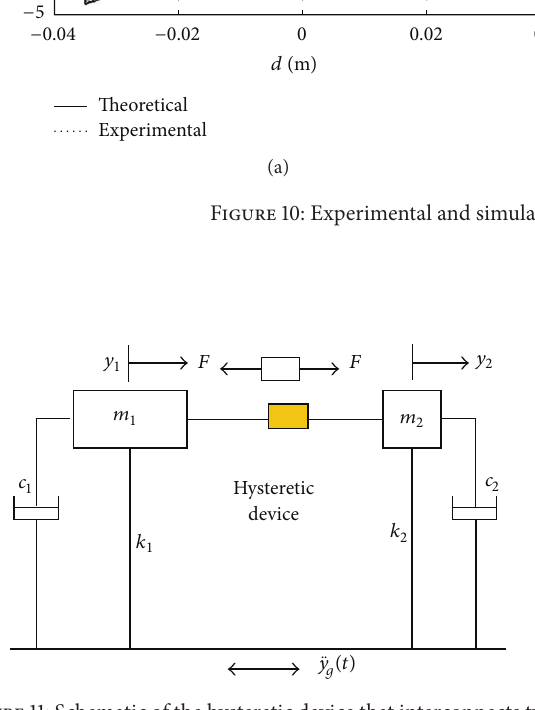
Figure 11: Schematic of the hysteretic device that interconnects two adjacent structures [13].